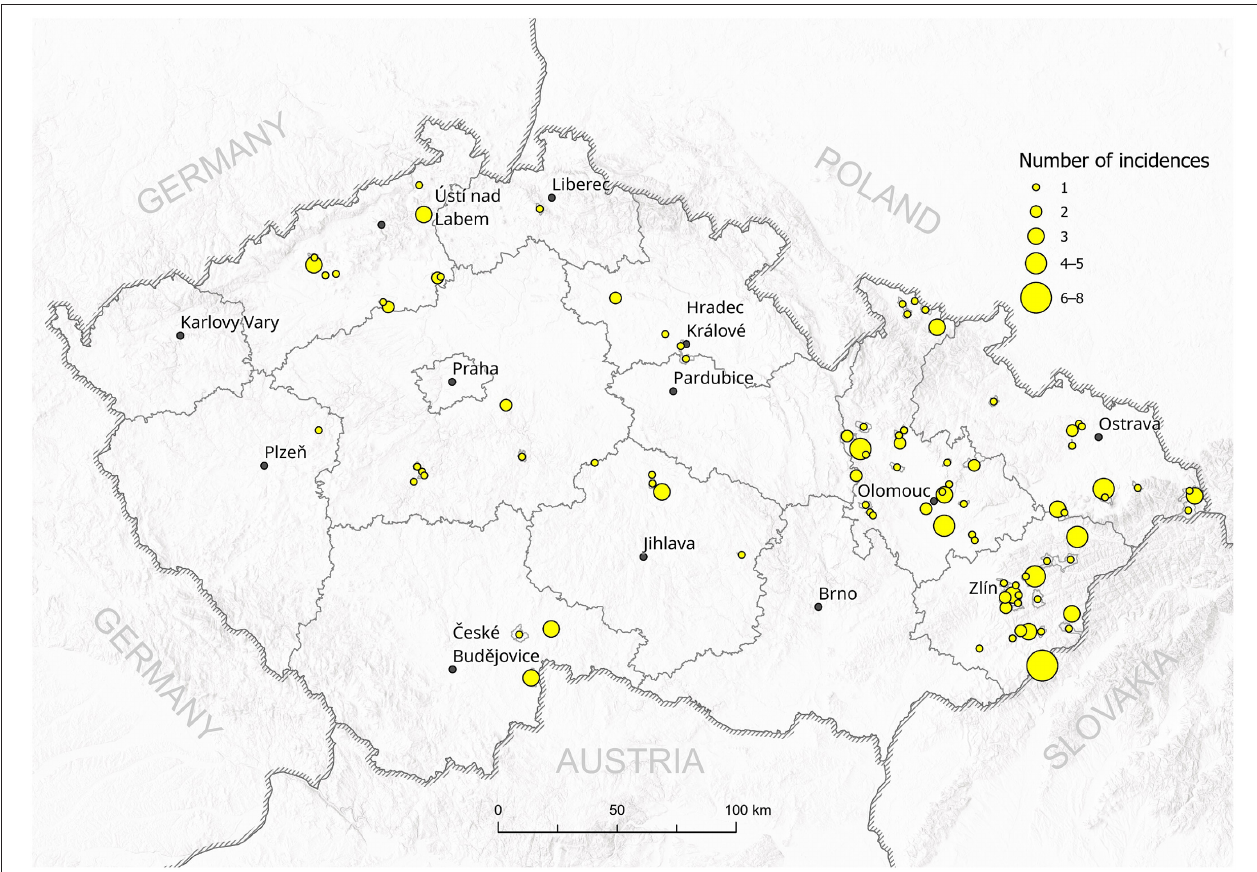
FIGURE 1 | Total incidences of AFB outbreaks in the Czech Republic between 2016 and 2017. The number of outbreaks in particular districts is represented by the size of the